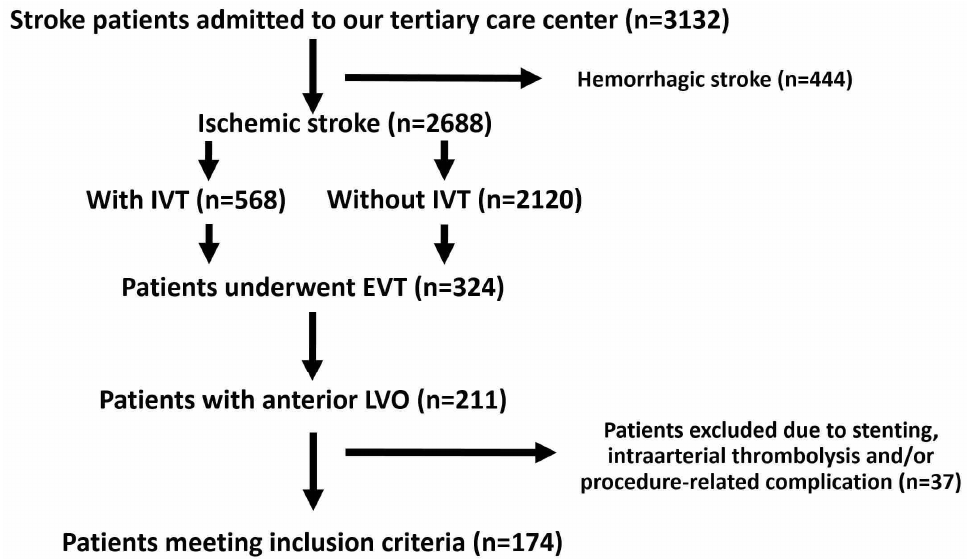
Figure 1. Flow chart of patient’s selection. Declaration of Abbreviations: IVT = intravenous throm- bolysis; EVT = endovascular thrombectomy; LVO = large vessel occlusion.